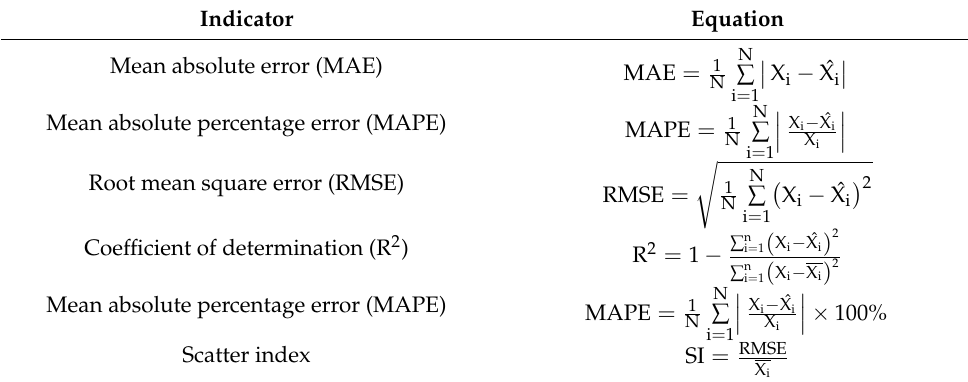
Table 6. Estimate criteria in recent